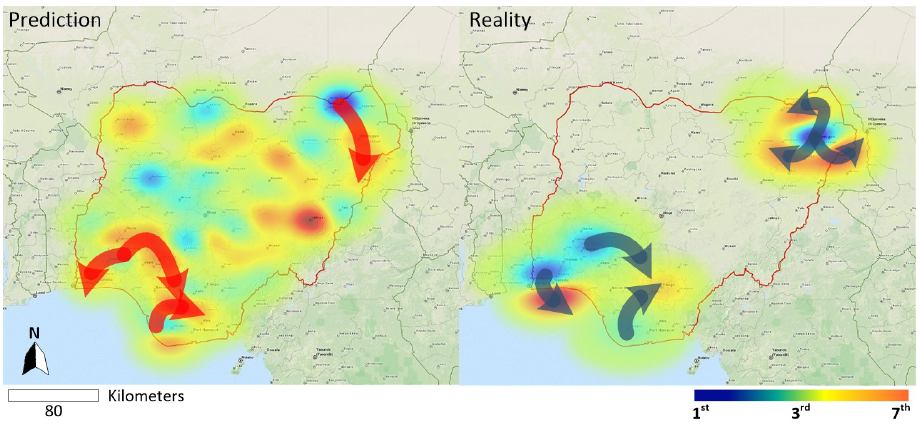
Figure 14. An example of an arrow trend chart comparison for the week of 1